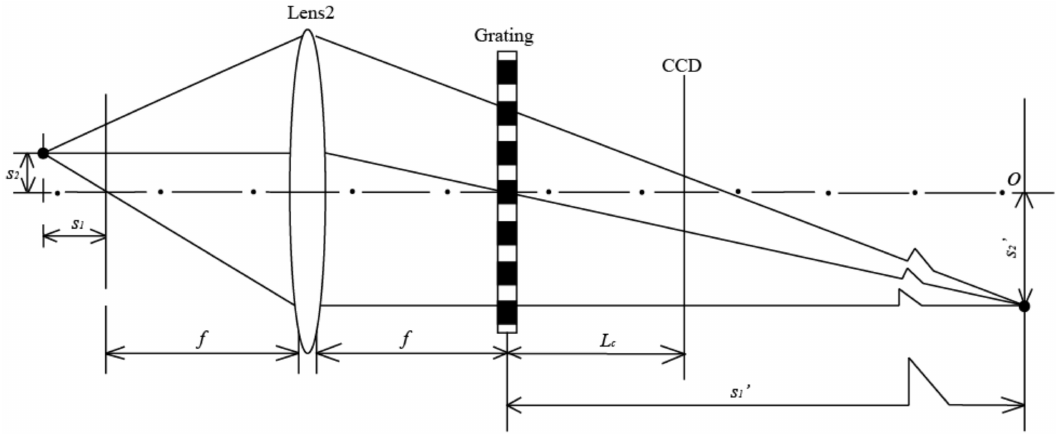
Figure 4. Element location of focus measurement system.